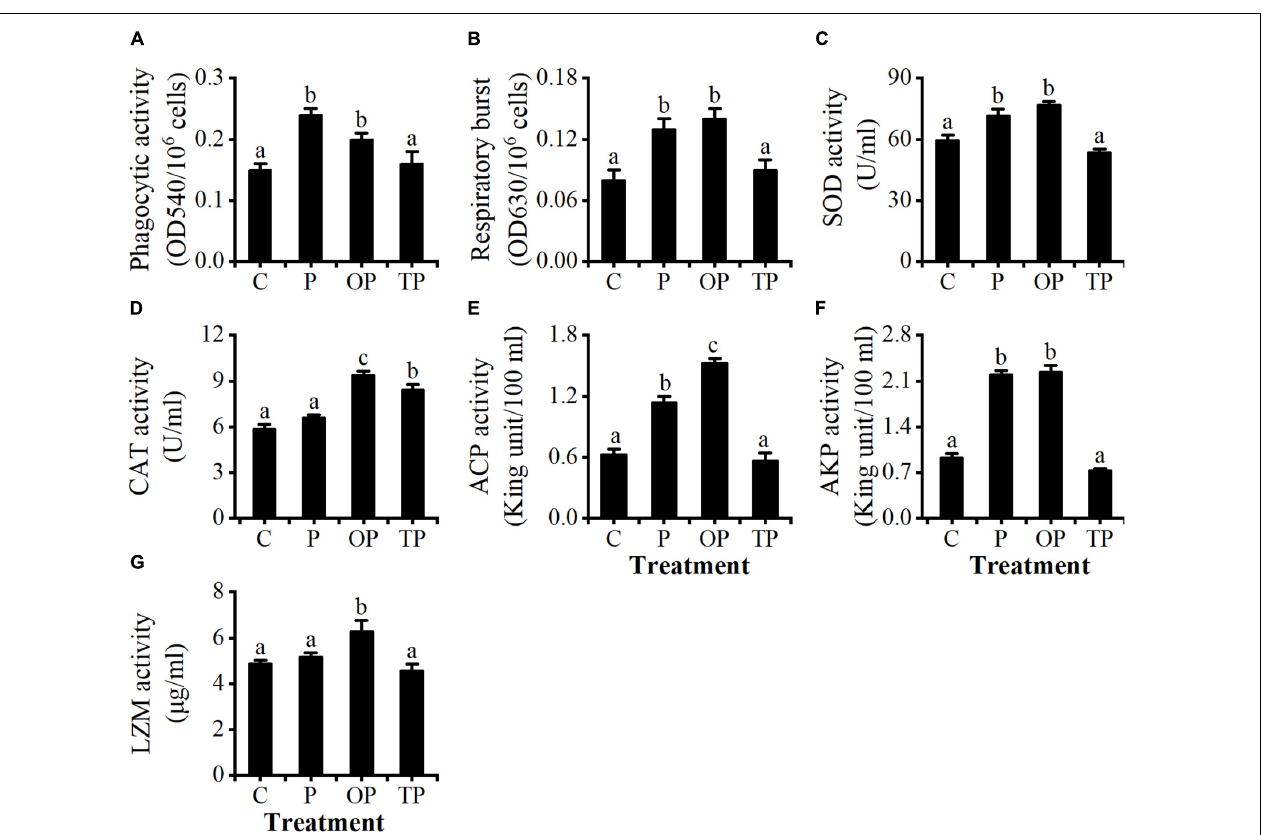
FIGURE 1 | Effects of dietary poly- β -hydroxybutyrate (PHB) on (A) phagocytic (PA), (B) respiratory burst (RB), (C) superoxide dismutase (SOD), (D) catalase (CAT), (E) acid phosphatase (ACP), (F) alkaline phosphatase (AKP), and (G) lysozyme (LZM) activity in the coelomocytes of sea cucumber ( Apostichopus japonicus ). Bars represent mean ± SE ( n = 5). Different letters in each figure represent significant differences ( P < 0.05). C (control): basal diet; P: basal diet supplementation with 0.5% PHB; OP: basal diet supplementation with 1% PHB; TP: basal diet supplementation with 3% PHB.